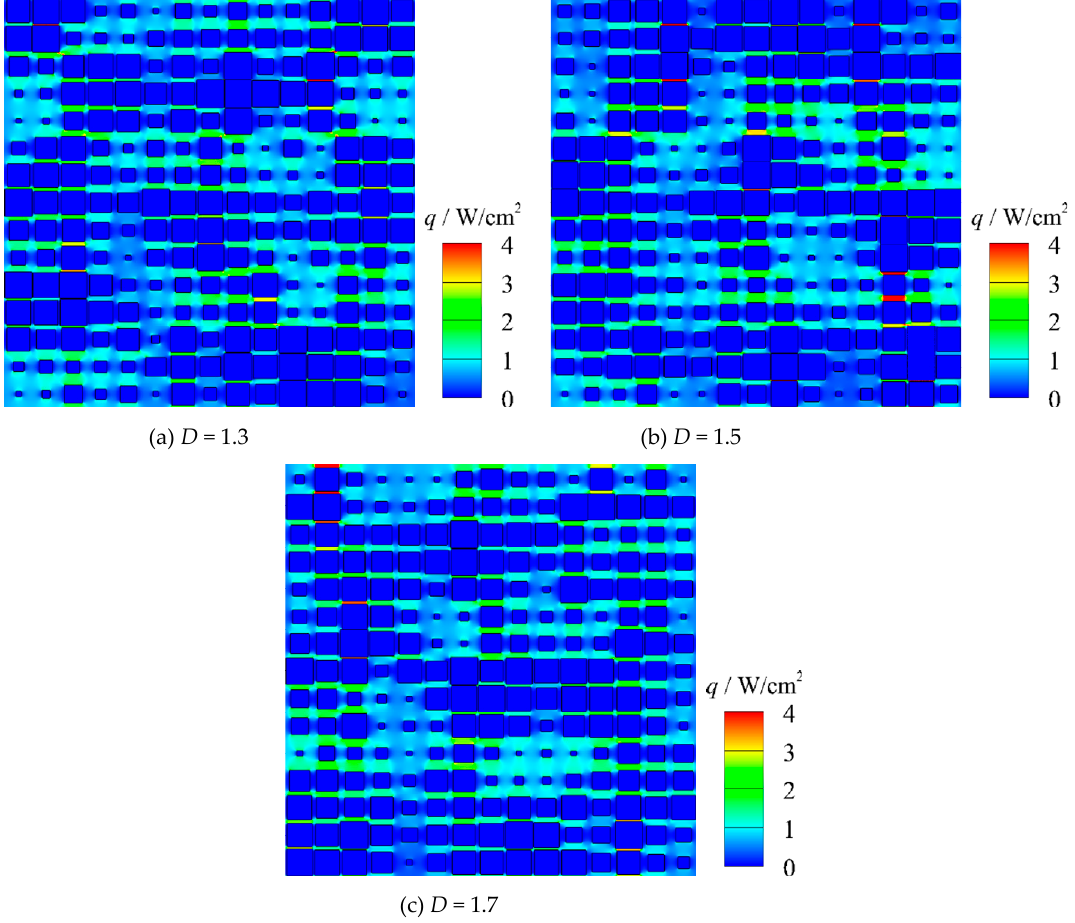
Figure 7. Effect of fractal dimension on heat flux distributions of porous material ( ε = 0.5): ( a ) D = 1.3; ( b ) D = 1.5; ( c ) D = 1.7.